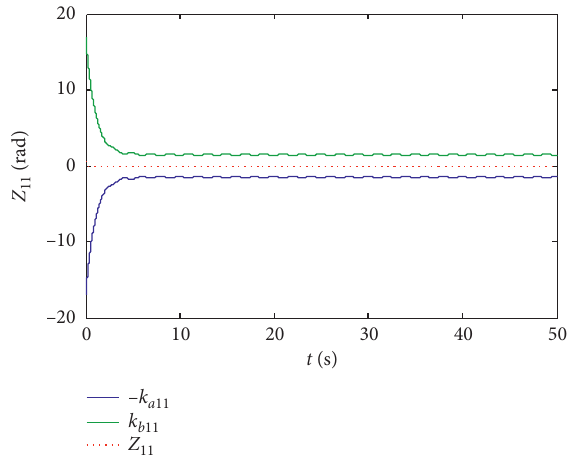
Figure 21: Constraint effect of Z